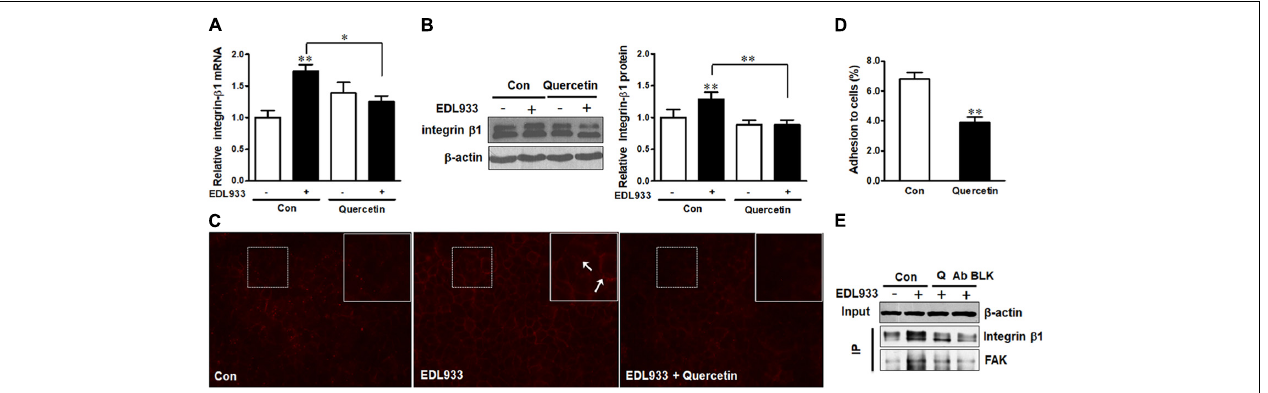
FIGURE 7 | Quercetin reduced E. coli O157:H7 adhesion and prevented integrin β 1 overexpression induced by E. coli O157:H7 infection. (A,B) mRNA expression and protein level of integrin β 1. (C) Immunofluorescence staining of integrin β 1. Red, integrin β 1. Images were taken at 200 × magnification. (D) Adhesion of EDL933 to Caco-2 cells treated with or without quercetin. (E) Co-immunoprecipitation analysis of integrin β 1 and FAK interaction. Input, the whole cell lysate detected with β -actin; IP, the immunoprecipitated lysates were detected with integrin β 1 or FAK antibody. Caco-2 cells were pretreated with 0 or 200 µ M quercetin for 12 h, then followed by infection with EDL933 strain for 4 h when cells were collected for respective assays. Means ± SEM; n = 4. ∗∗ P ≤ 0.01; ∗ P ≤ 0.05.